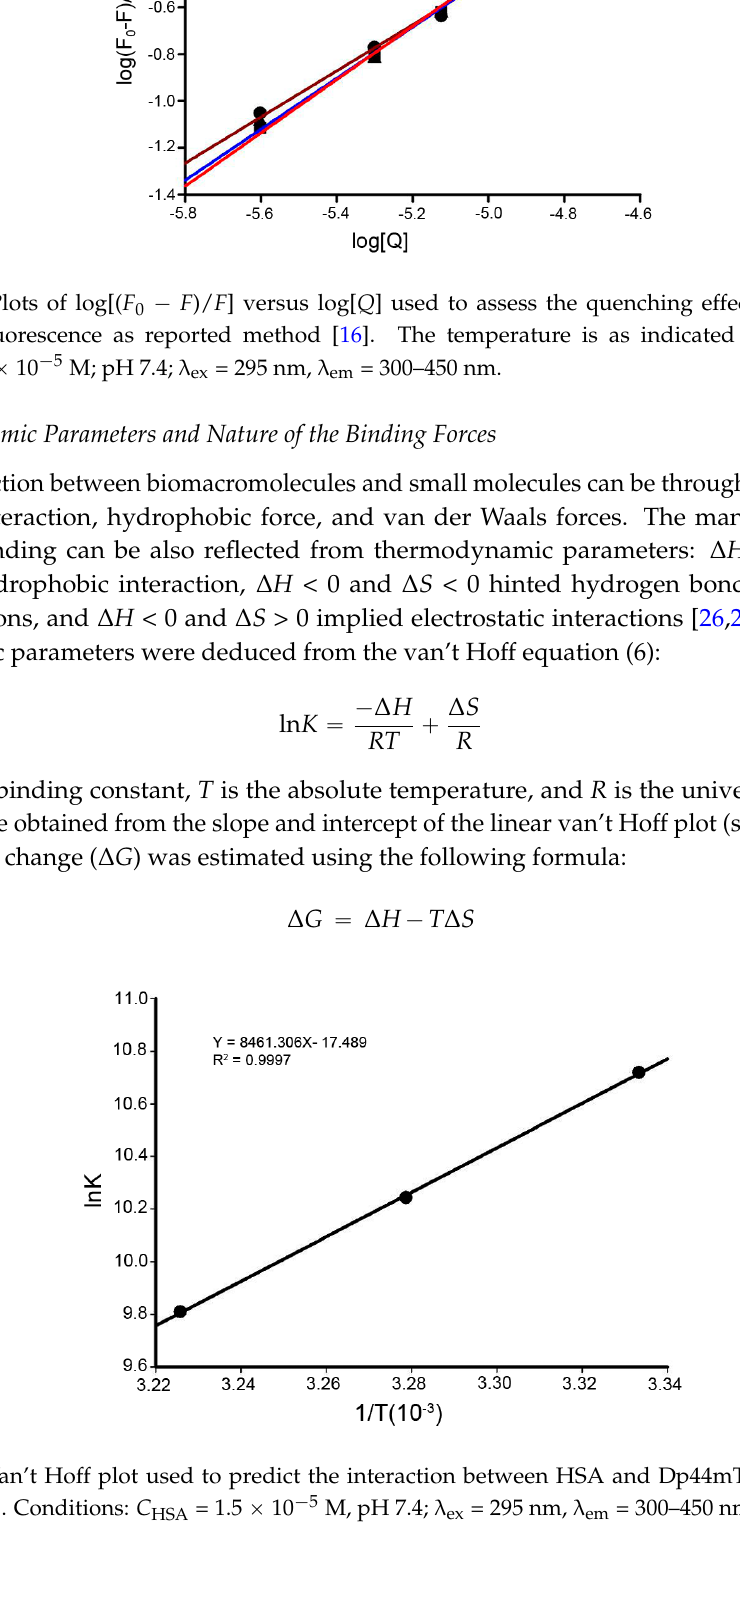
method [16]. Conditions: C HSA = 1.5 × 10 − 5 M, pH 7.4; λ ex = 295 nm, λ em = 300–450 nm.